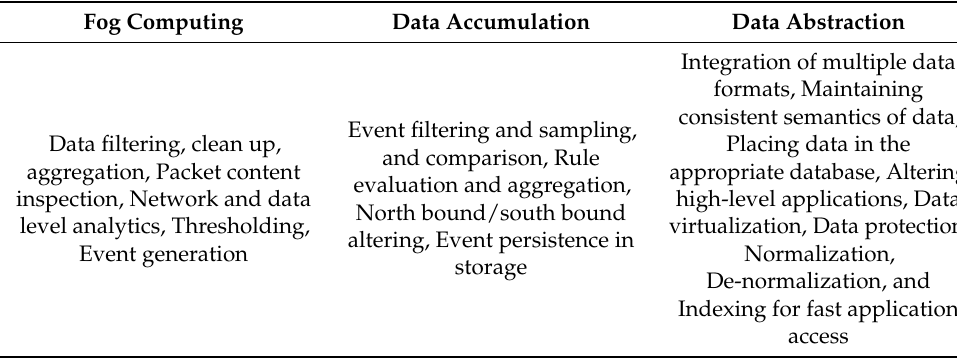
Table 6. Responsibilities of IoT data handling